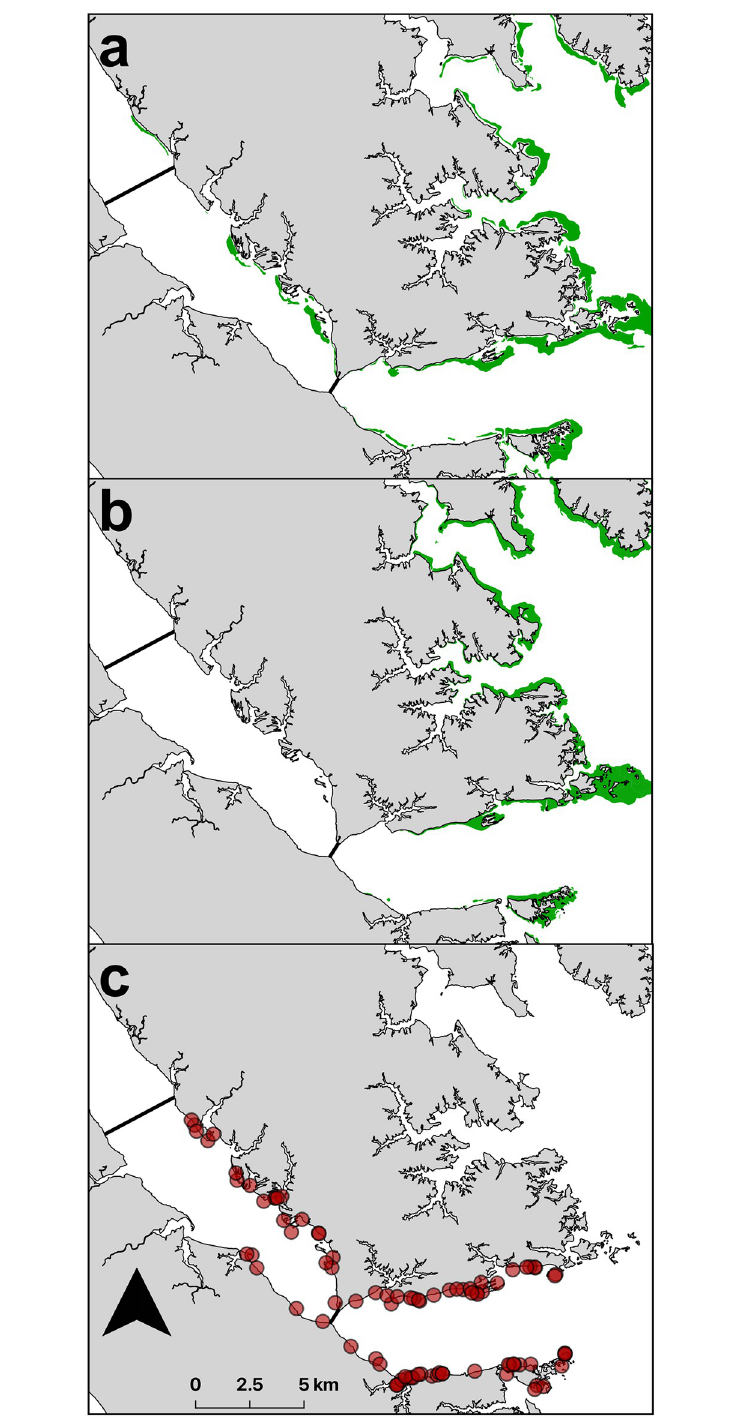
Fig 9. Locations within the York River of (a) seagrass cover (green) in 1971 [92], (b) seagrass cover (green) in 2014 [66], and (c) sites where Gracilaria vermiculophylla was present in both 2013 and 2014.